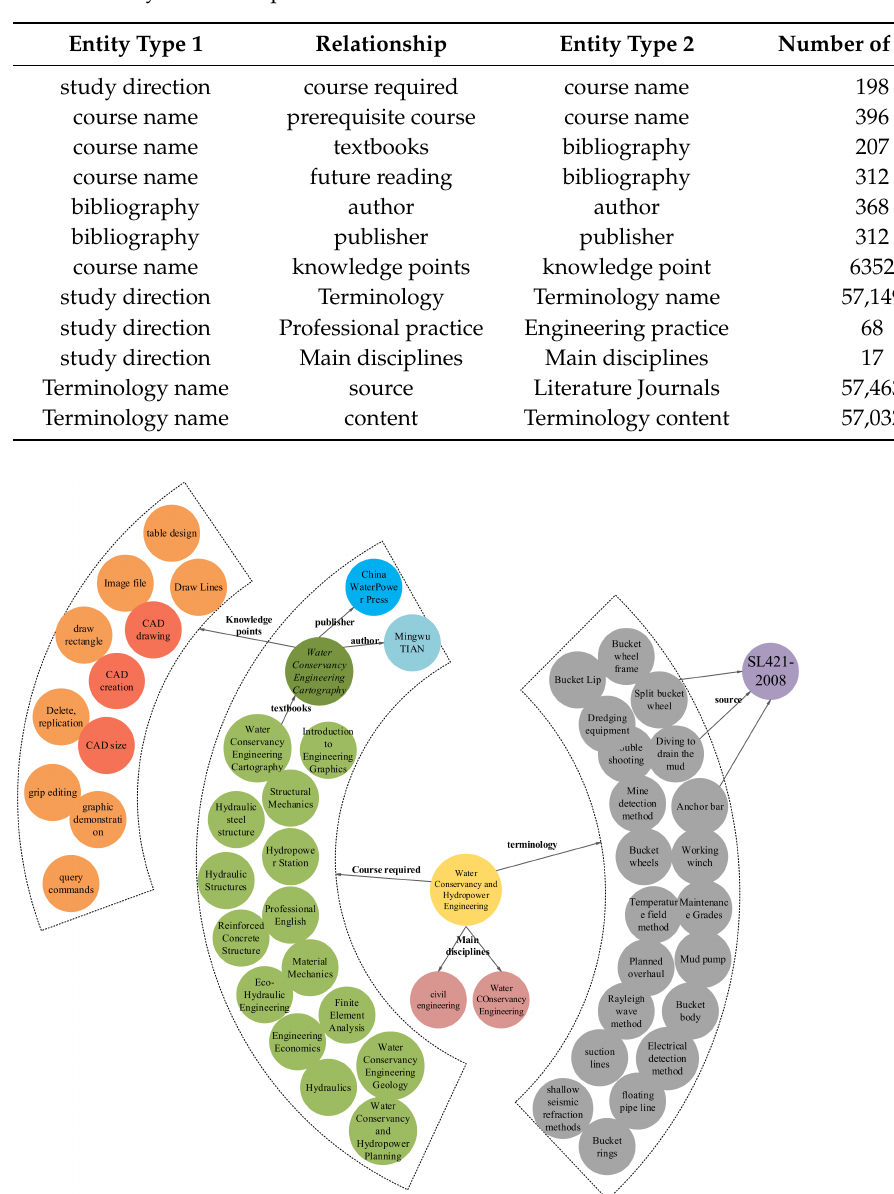
Figure 5. Abstract Storage Structure of Some Entities and